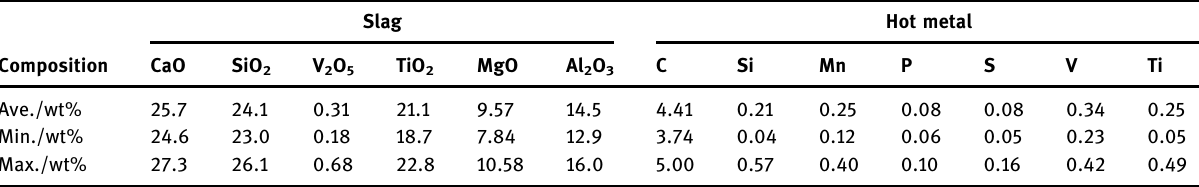
Table 2: Compositions of slag and hot metal in the VTM smelting BF Slag Hot metal